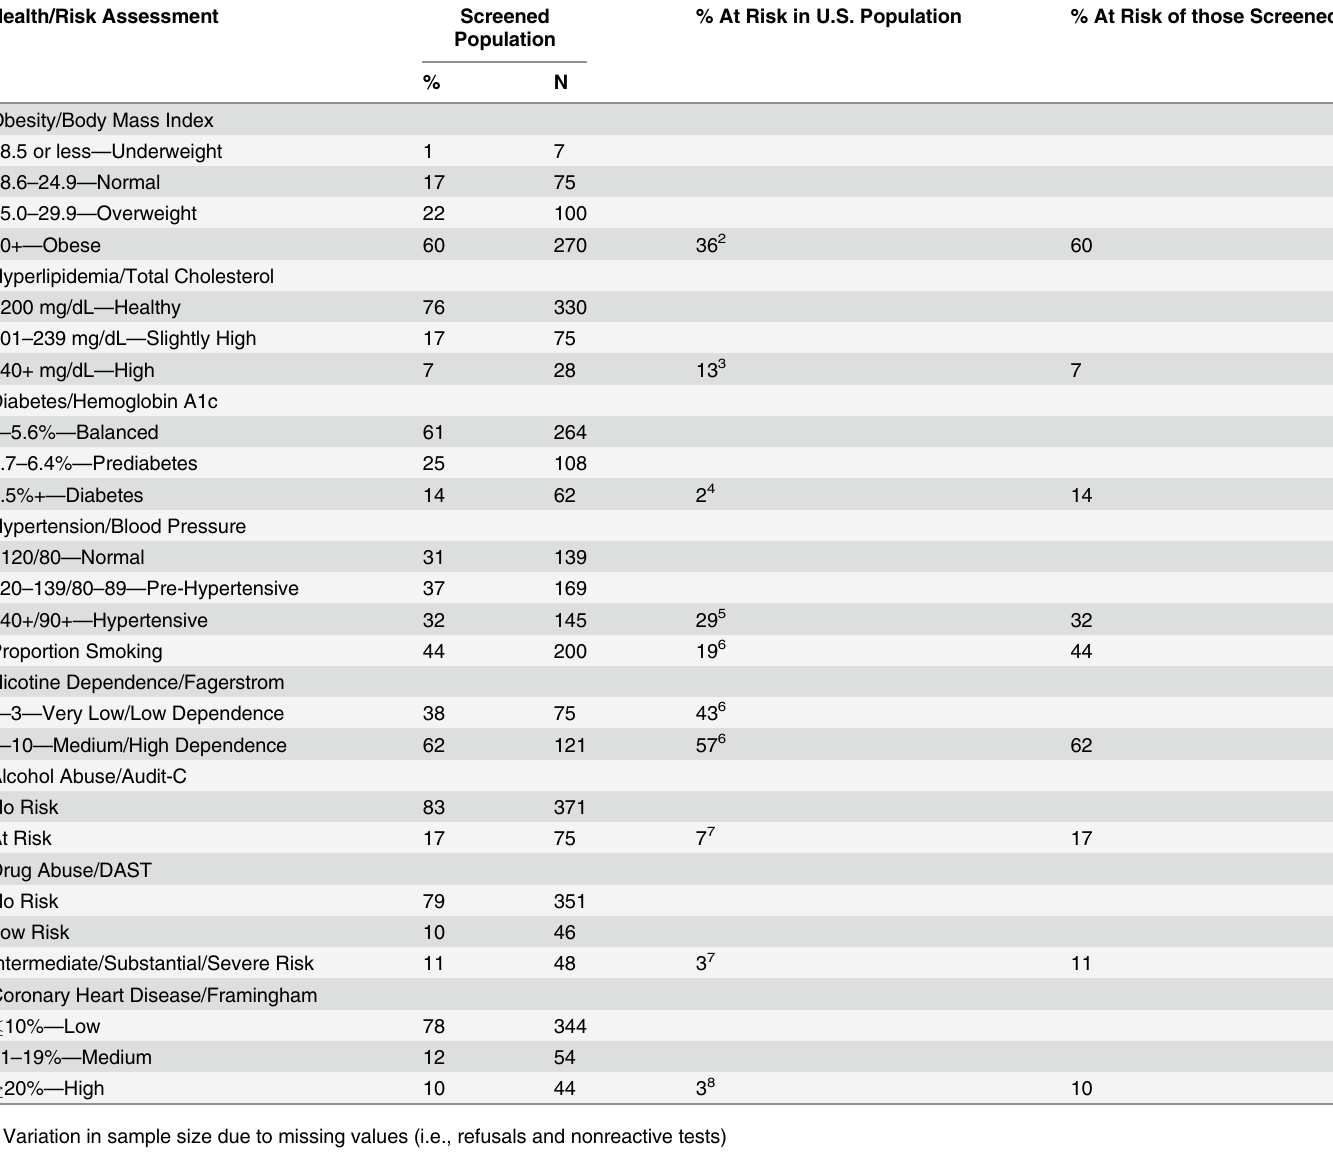
Table 2. Results of health risk assessments and comparison with U.S. population (N = 457) 1